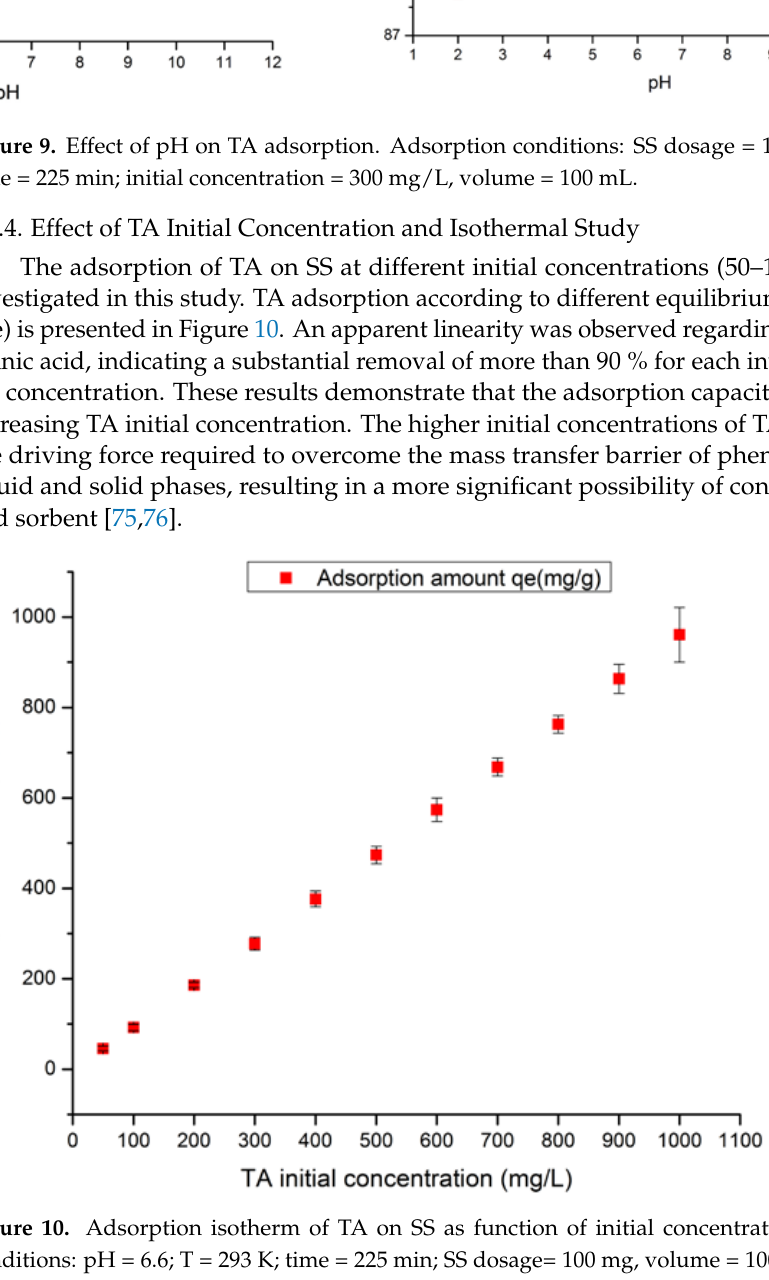
Figure 9. Effect of pH on TA adsorption. Adsorption conditions: SS dosage = 100 mg; T = 293 K; time = 225 min; initial concentration = 300 mg/L, volume = 100 mL.